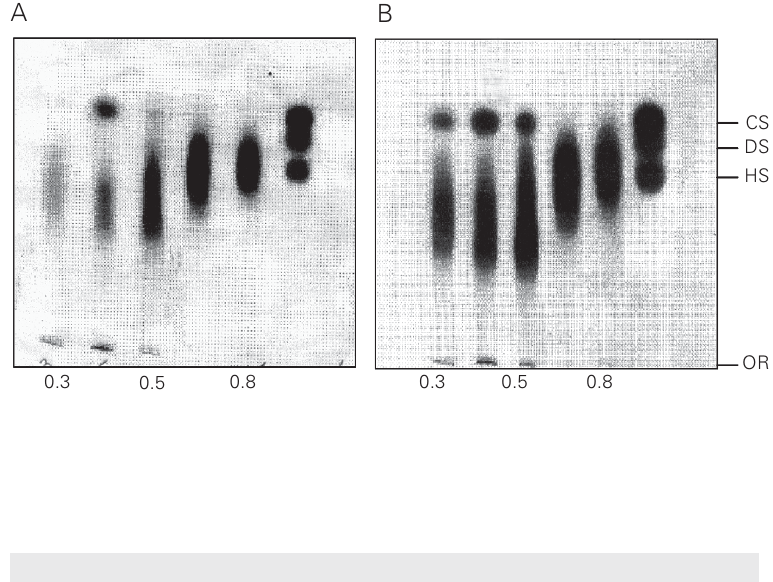
Figure 2. Gel filtration of fraction 1.0. The fraction precipitated with 1.0 volume of acetone was applied to a Sephadex G-75 column (1.8 x 120 cm). The col- umn was eluted with 0.2 M acetic acid, 1-ml fractions were collected and the effluent was analyzed for the presence of sugars by the phenol-H 2 SO 4 method (20). The arrows indicate the void volume (V 0 ) and the total volume (V t